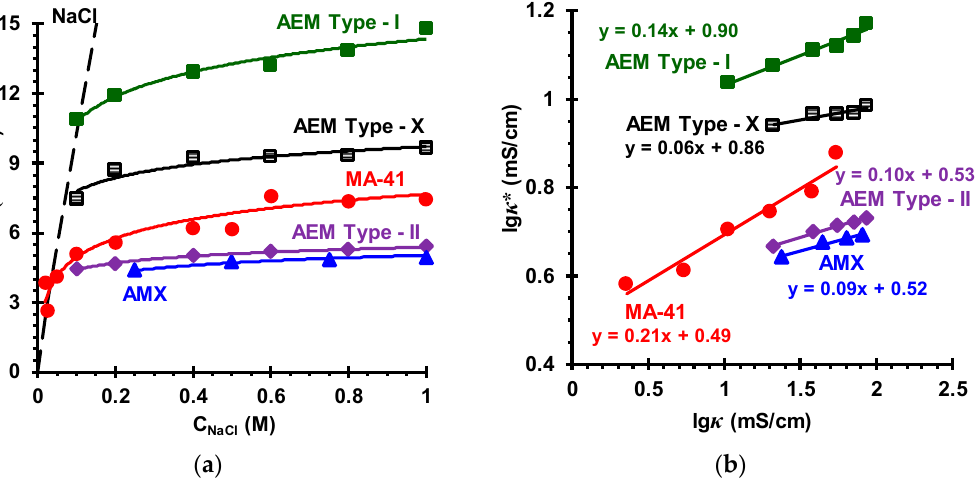
Figure 8. Concentration dependences of the conductivity of different anion-exchange membranes, κ *, in NaCl solutions ( a ) and the lg κ * vs. lg κ dependences of these membranes in NaCl solutions ( b ). The names of the membranes are indicated near the curves, which fit the experimental data. The dashed line in the figure ( a ) is the concentration dependence of the NaCl solution conductivity. Table 4. The values of conductivity at the isoconductivity points, volume fraction, exchange capacity of and counterion diffusion coefficient in the gel phase of the investigated membranes in NaCl solution.